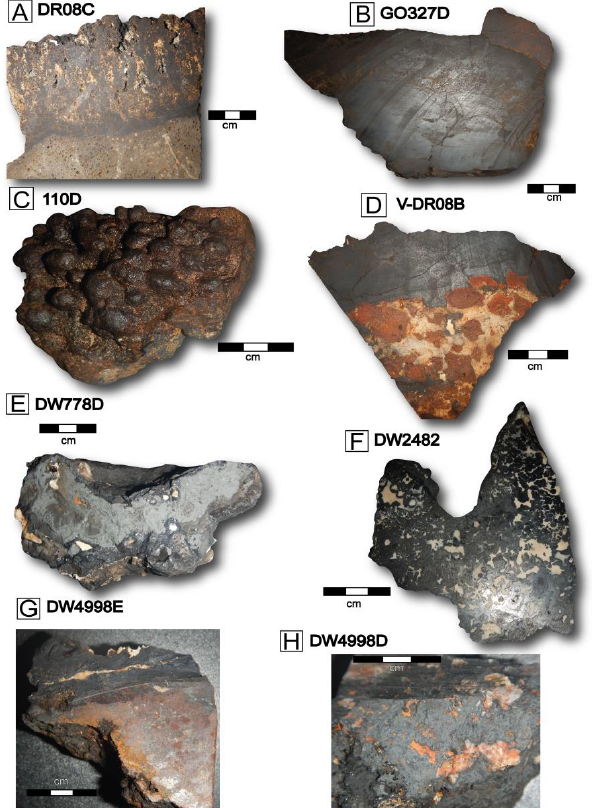
Figure 3. Fe-Mn deposits photographs with centimetre scale bars. ( A ) Cross-section of DR08C showing a columnar/porous texture with interstitial sediments filling pores, deposited on a vacuolar basalt; ( B ) Cross section of the thickest crust sample of the data set GO327D, four layers are identified and sub-sampled; ( C ) Current-polished centimetre-scale botryoidal surface of sample 110D; ( D ) V-DR08B showing massive/laminated textures without any sub-layers deposited on a hyaloclastite breccia; ( E ) Hydrothermal deposit from sample DW778D; ( F ) Imbrication of Mn-rich and Ca-rich zones in sample DW2482; ( G ) Sample DW4998E composed primarily of 10 Å manganates and calcite on a strongly altered hyaloclastite breccia impregnated with Fe-oxyhydroxides; ( H ) Sample DW4998D showing a metallic grey Mn-rich zone and fluorapatite/Mg-calcite/calcite area.